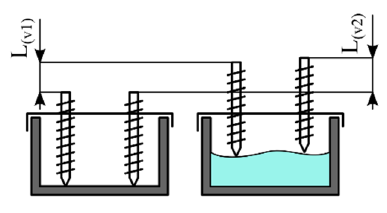
Fig. 4. Measuring of the water depth in the channel .